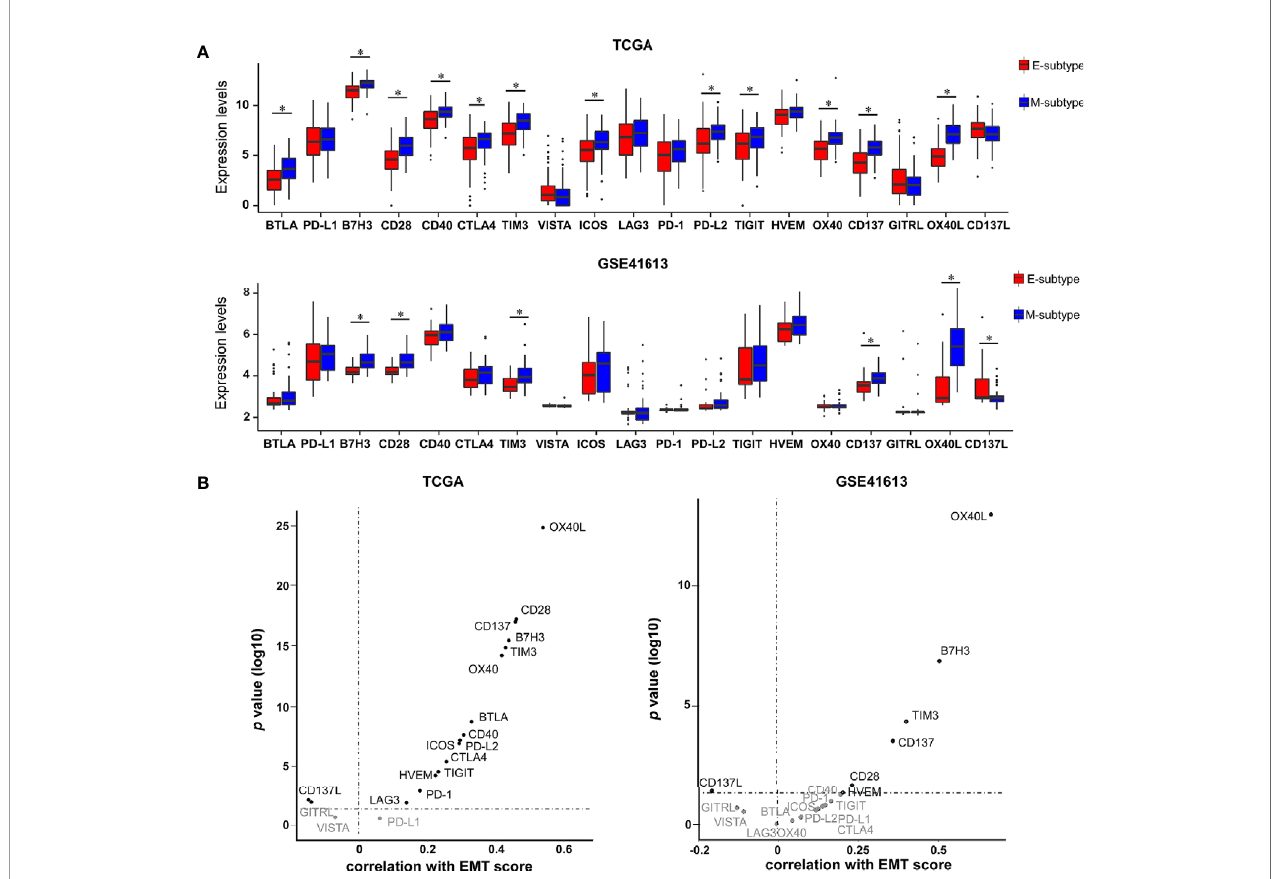
FIGURE 6 | The expression levels of immune checkpoints are elevated in M-subtype OSCC. (A) The mRNA levels of 19 immune checkpoints in E- and M-subtypes. (B) The correlation of EMT scores and 19 immune checkpoints expression levels. * p value < 0.05, mean ± s.d., student ’ s t